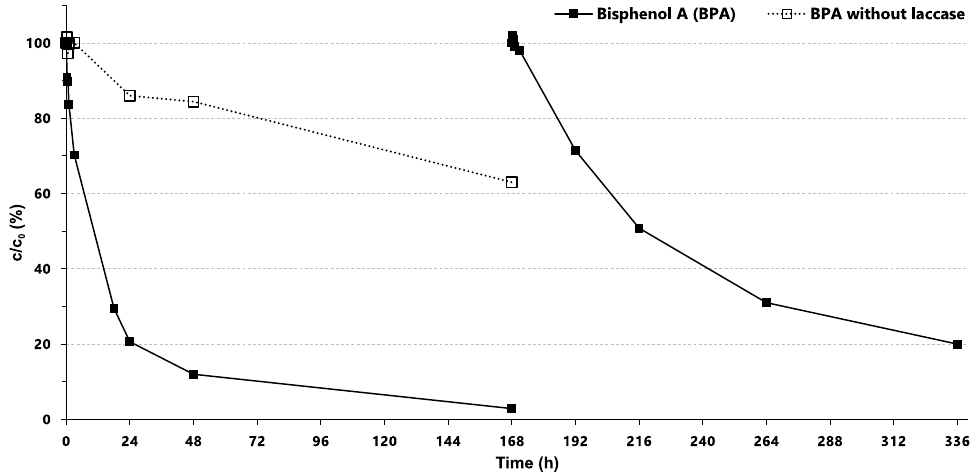
Figure 4. Oxidative elimination of BPA with BT-PEMA bound laccase from Trametes versicolor over two periods of one week. After the first week, the same amount of pollutants was added again (second cycle). Dotted curves represent the same setup with BT pieces without laccase. n